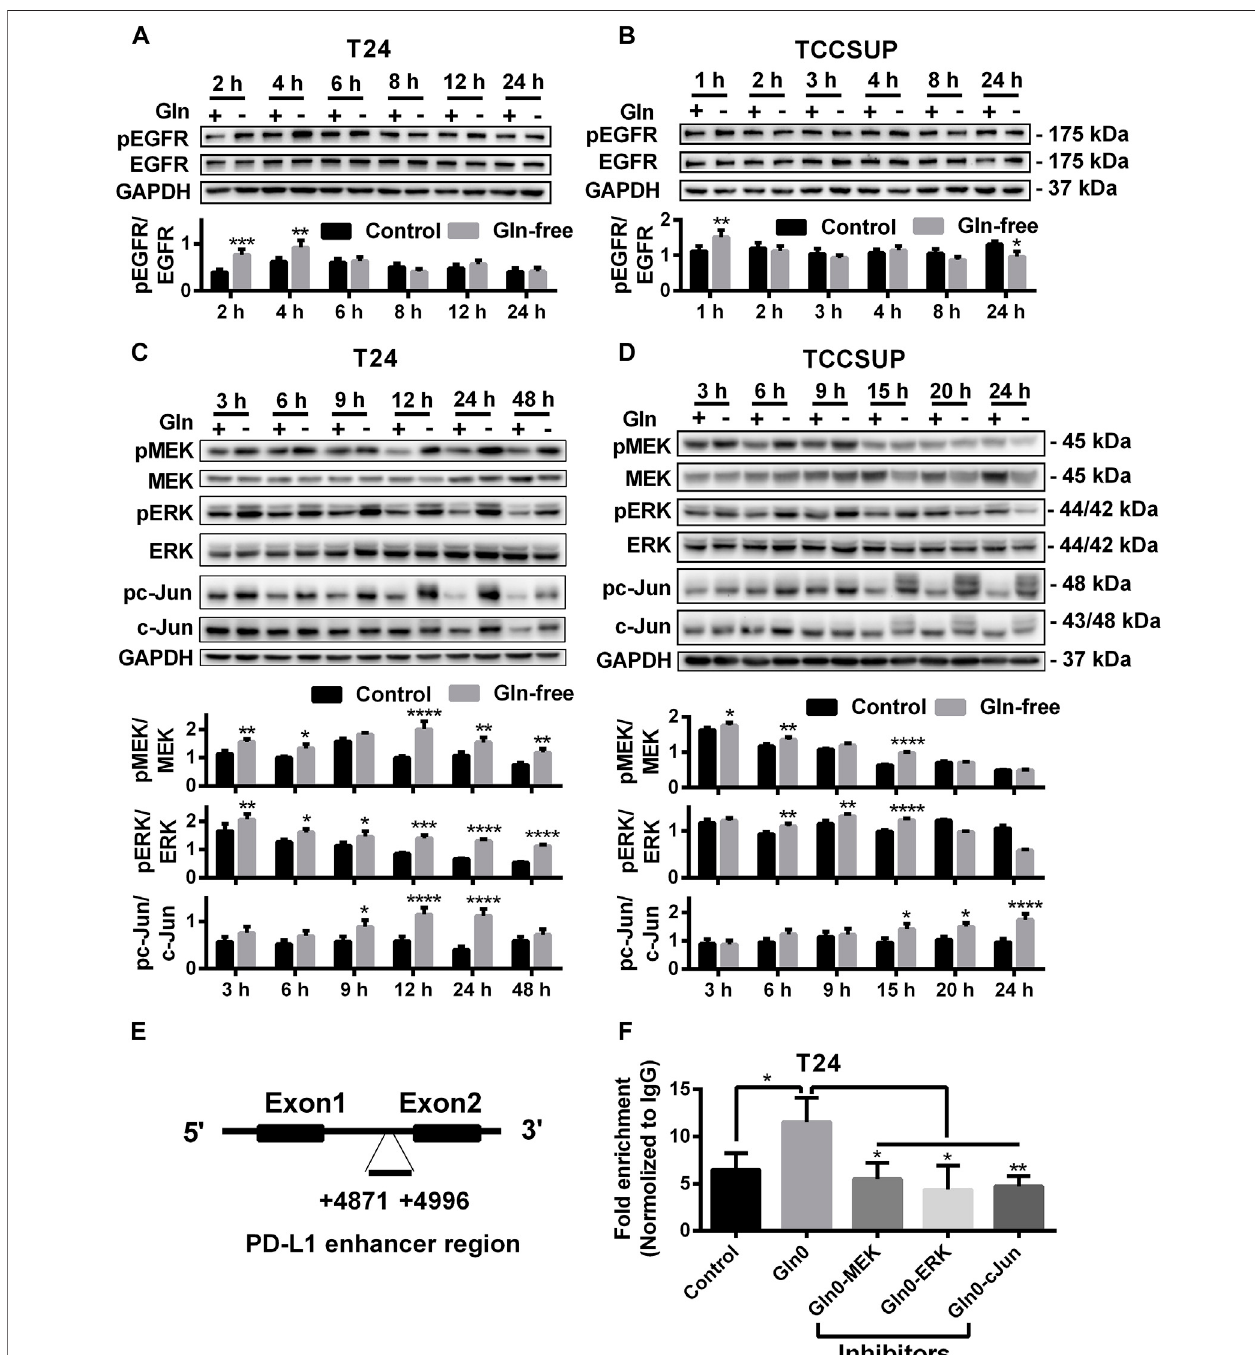
FIGURE 2 | The protein levels of the EGFR/MEK/ERK/c-Jun pathway by glutamine deprivation. (A) The protein level of pEGFR in T24 cells after culturing in glutamine-free culture medium for 2 – 24 h (+: glutamine 300 mg/L; -: glutamine 0 mg/L). (B) The protein level ofpEGFR in TCCSUP cells after culturing in glutamine-free culture medium for 1 – 24 h. (C) The protein levels of pMEK, pERK and pc-Jun in T24 cells after culturing in glutamine-free culture medium for 3 – 48 h. (D) The protein levelsofpMEK,pERKandpc-JuninTCCSUPcellsafterculturinginglutamine-freeculturemediumfor3 – 24 h. (E) ThebindingregionoftheAP-1componentc-Jun to the PD-L1 enhancer. (F) C-Jun enrichment at the PD-L1 gene enhancer in the control and glutamine deprivation with or without inhibitors was performed by ChIP coupled with qPCR. Ratio quanti fi cation of the speci fi c phosphorylations was analysed. The results were considered signi fi cant at p < 0.05 (* p < 0.05, ** p < 0.01, *** p < 0.001, **** p <